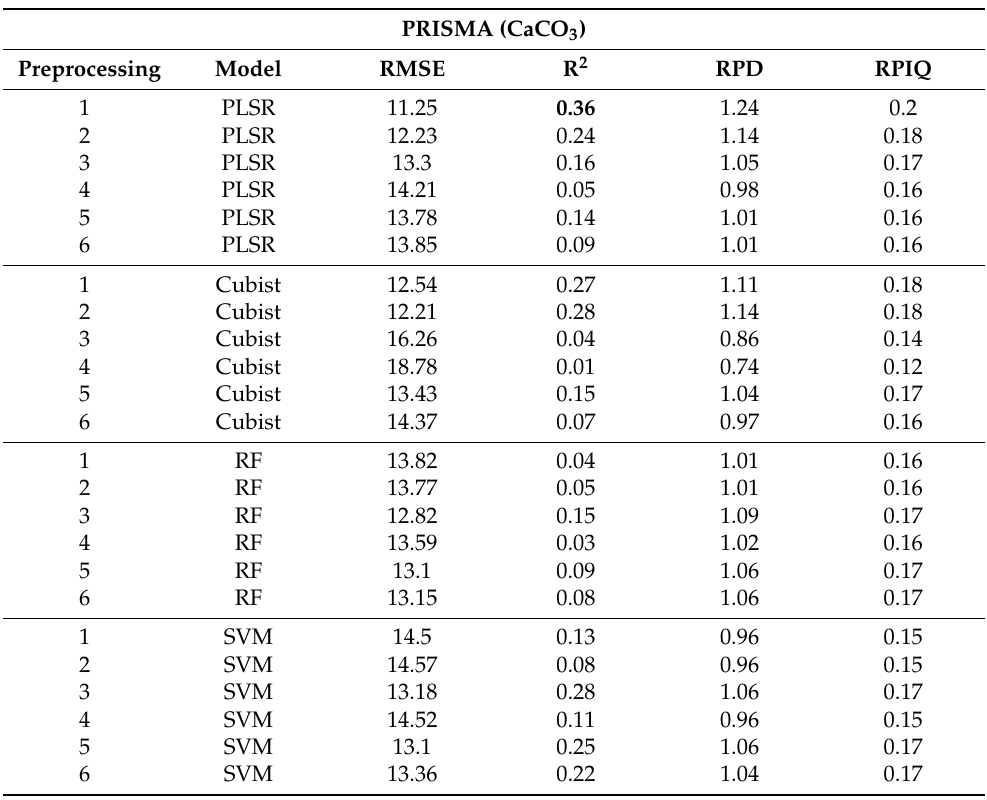
Table A6. Statistical evaluation of the models used to predict the calcium carbonate content (CaCO 3 ) from the PRISMA